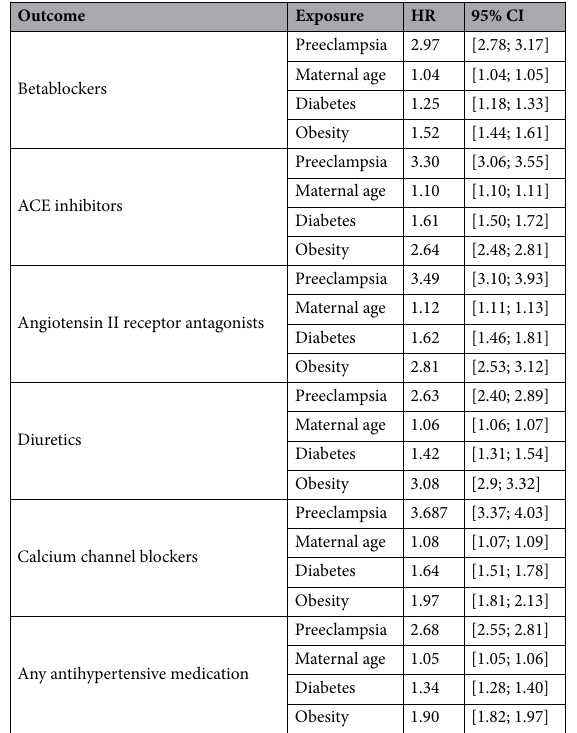
Table 3. Cox proportional regression models onto first prescription of antihypertensive medications by risk exposures. Data are expressed as hazard ratios (HR) with 95% CI. Cox proportional regression modeling included age, diabetes, and obesity. Women with preexisting antihypertensive medication were excluded. P values not shown, as for each row p <